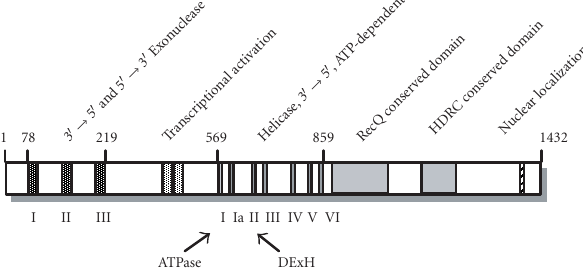
Figure 1. Functional domains of the WRN protein. Arabic numbers in- dicate amino acids of the WRN protein. The designated functions of the exonuclease domains (I–III), the acidic repeat transcriptional activator re- gions, helicase domains (I–VI), and nuclear localization signal have been demonstrated in various biological assays. The roles of the RecQ C-terminal conserved region and the helicase RNaseD C-terminal (HDRC) conserved regions are based on the structural